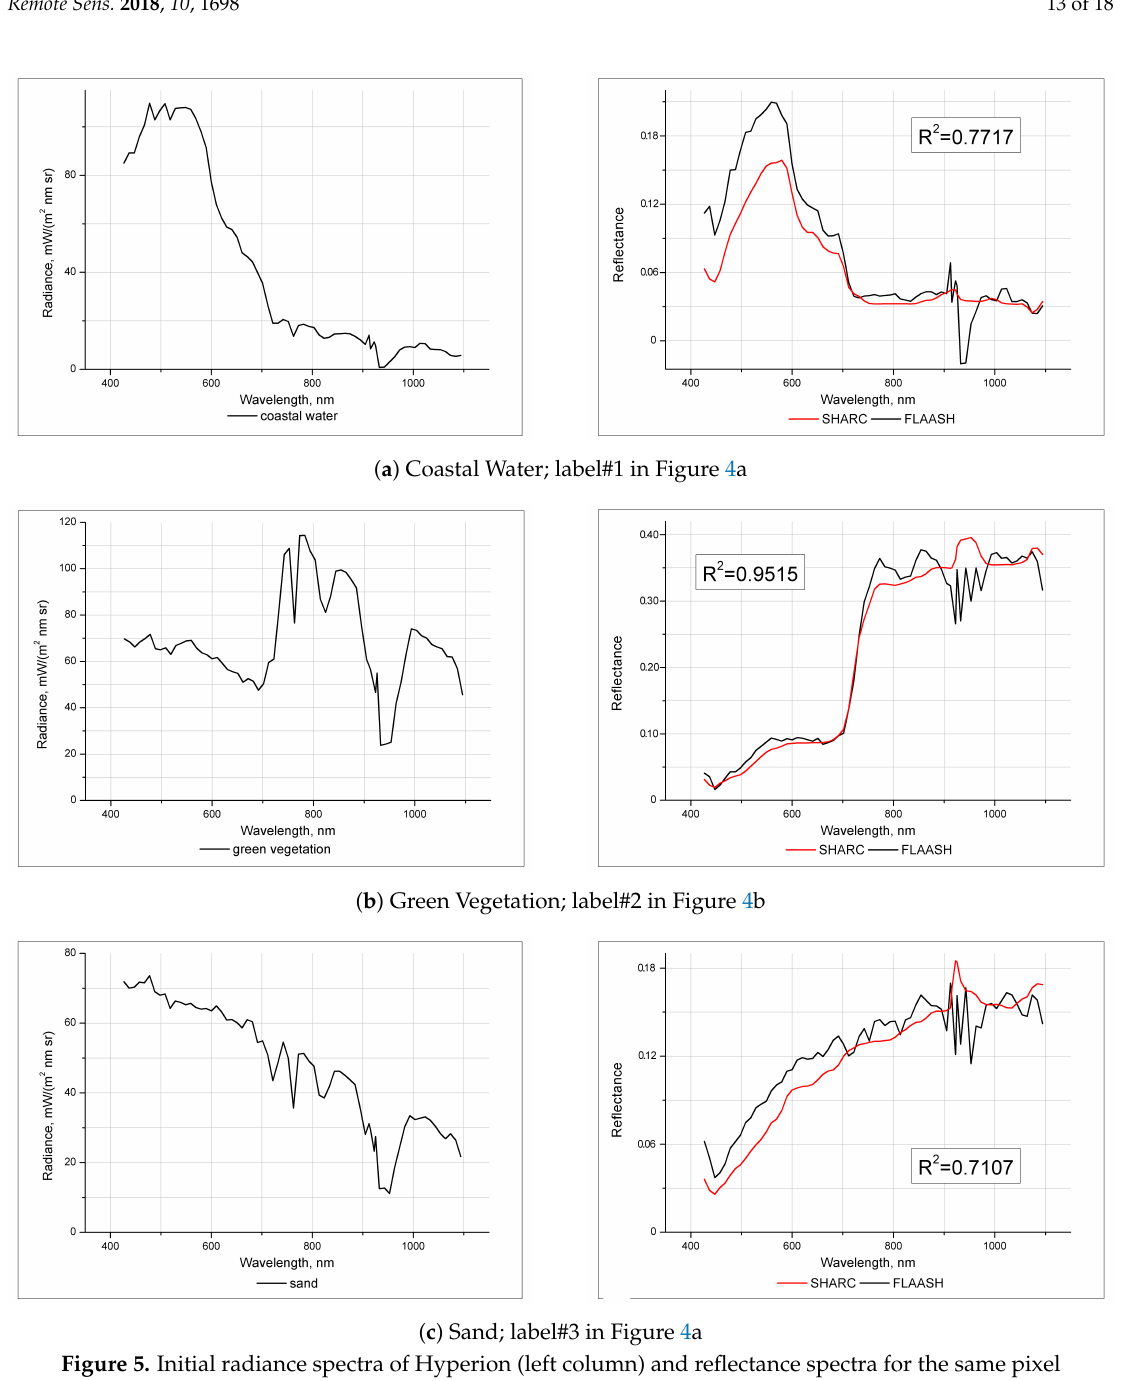
Figure 5. Initial radiance spectra of Hyperion (left column) and reflectance spectra for the same pixel retrieved by the SHARC atmospheric correction technique (right column) and FLAASH module (ENVI) (right column) for three types of underlying surfaces (coastal water ( a ), green vegetation ( b ), sand ( c )), labeled with pins in Figure